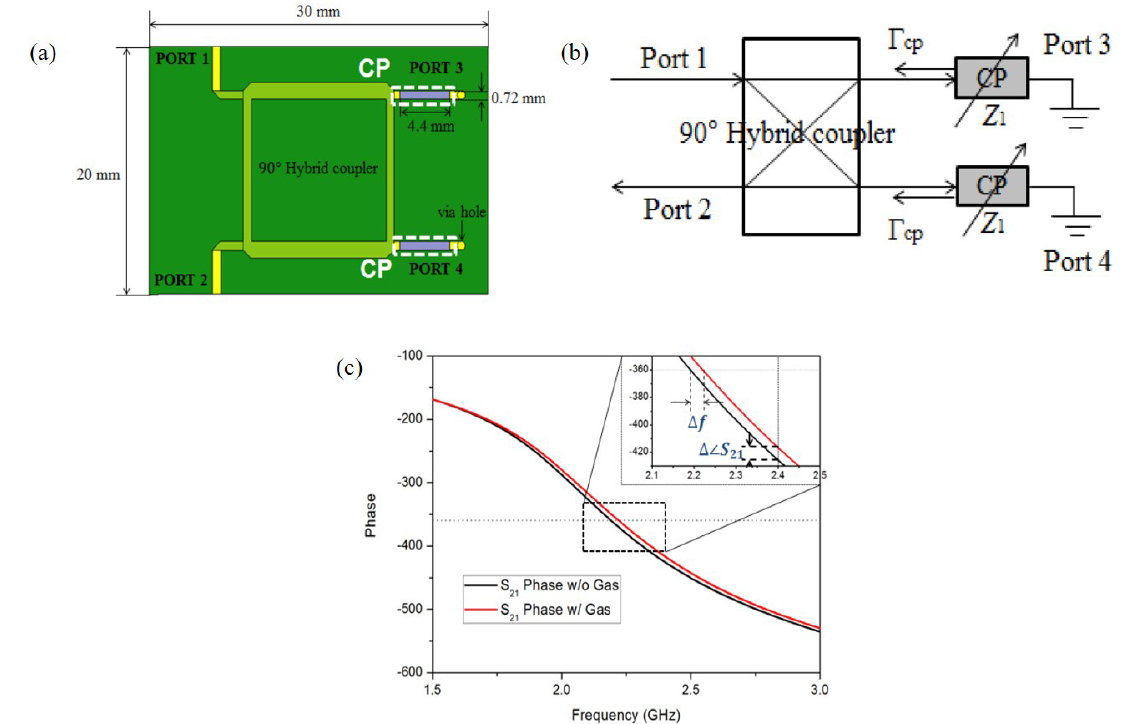
Figure 12. Ethanol gas sensor with hybrid coupler and PEDOT:PSS. ( a ) Schematic diagram of the sensor. ( b ) Equivalent circuit of the sensor. ( c ) Phase response of the sensor with and without ethanol gas